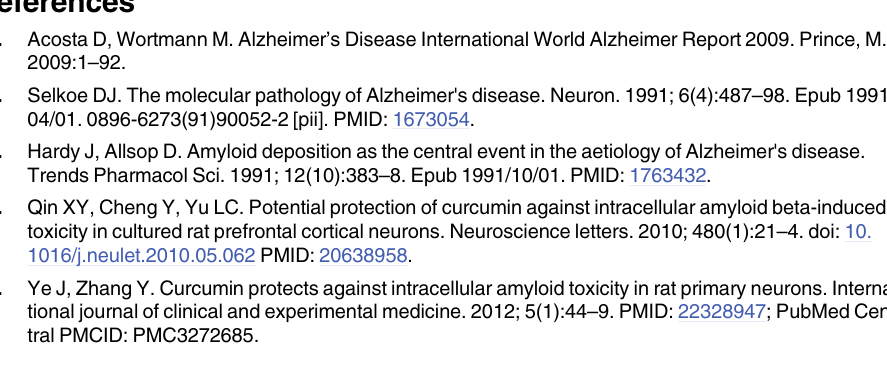
S1 Fig. Visible platform version of MWM of A β 1 – 42 injected and sham rats. Performance in the Morris water maze using cued platform training was assessed by (A) escape latency, (B) swim velocity during 5 training days. Each point represents the mean ± SEM for the two trials of each group on each day. n = 6/group. S2 Fig. Effect of chronic curcumin treatment on spatial reference memory in sham rats. Curcumin (50, 100 and 200 mg/kg) was administrated i.p. for 5 consecutive days (Day 6 – 10) in rats without A β injection (ie. the sham+Cur group). (A) Swim speed in each training trial. (B) The escape latency during the water maze training trials. (C) The time spent in the target quad- rant and (D) the number of times crossing the platform in the probe task. n = 6/group. (TIF) S3 Fig. Immunohistochemistry in A β 1-42-induced model and control. Representative fig- ures of A β 1-42 immunohistochemistry from model (A) and control groups (B), respectively. Scale bar 20 μ m. The black arrows are showing the positive cells from immunostaining.